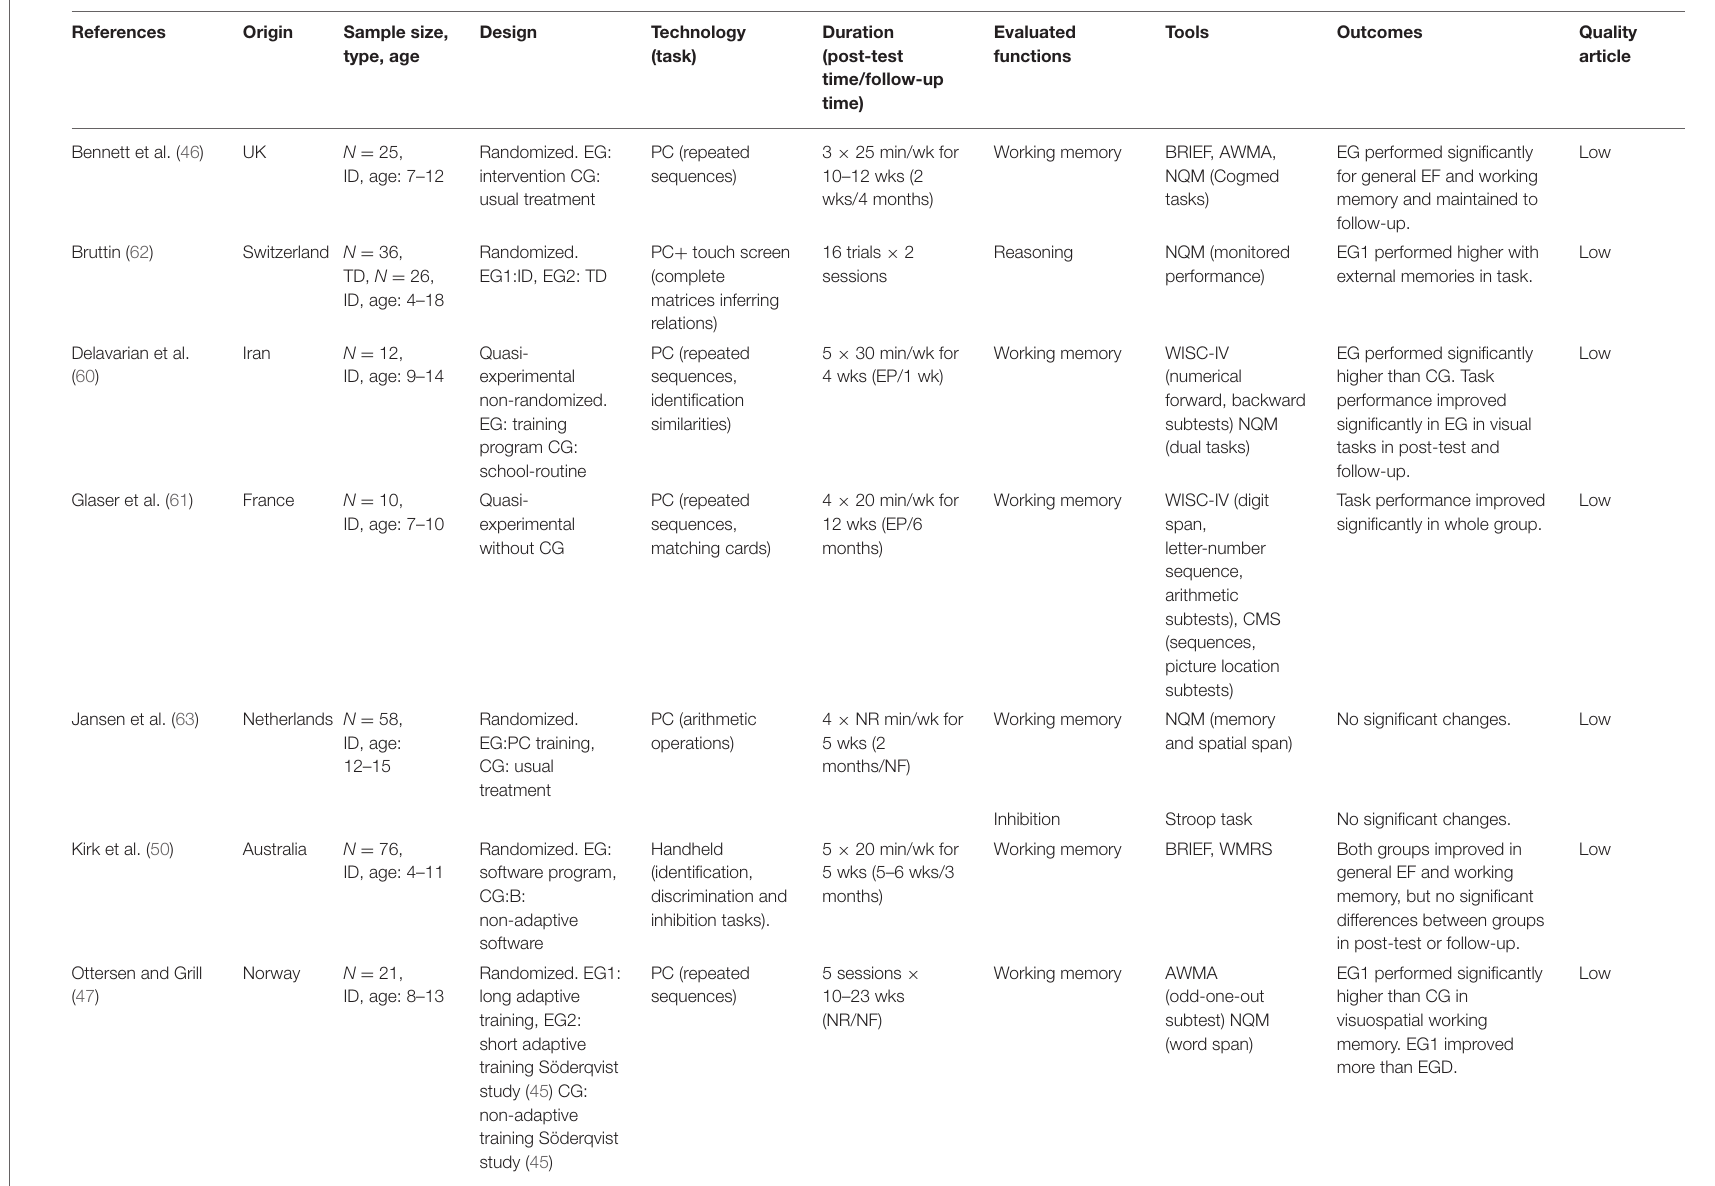
TABLE 2 | Reviewed studies focusing on executive